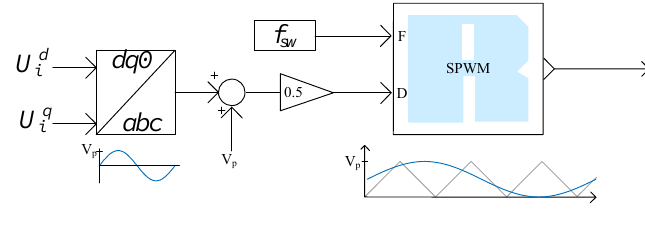
Figure 6. RTE-SPWM block and